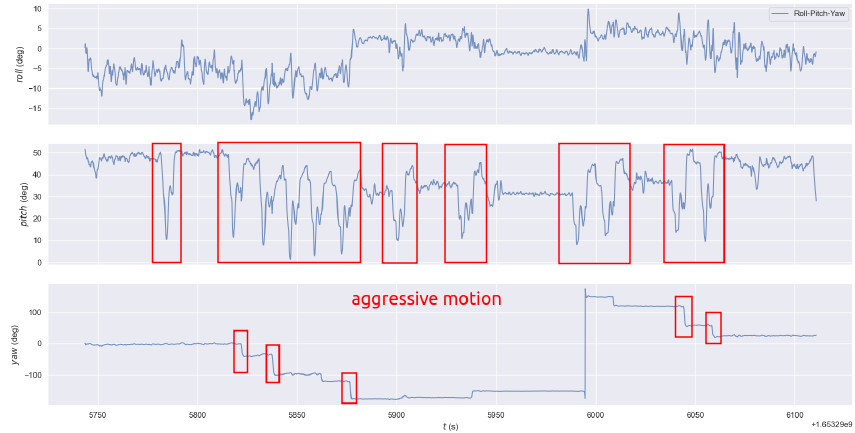
Figure 14. The Euler Angles of HZ-map dataset, which has an aggressive motion.